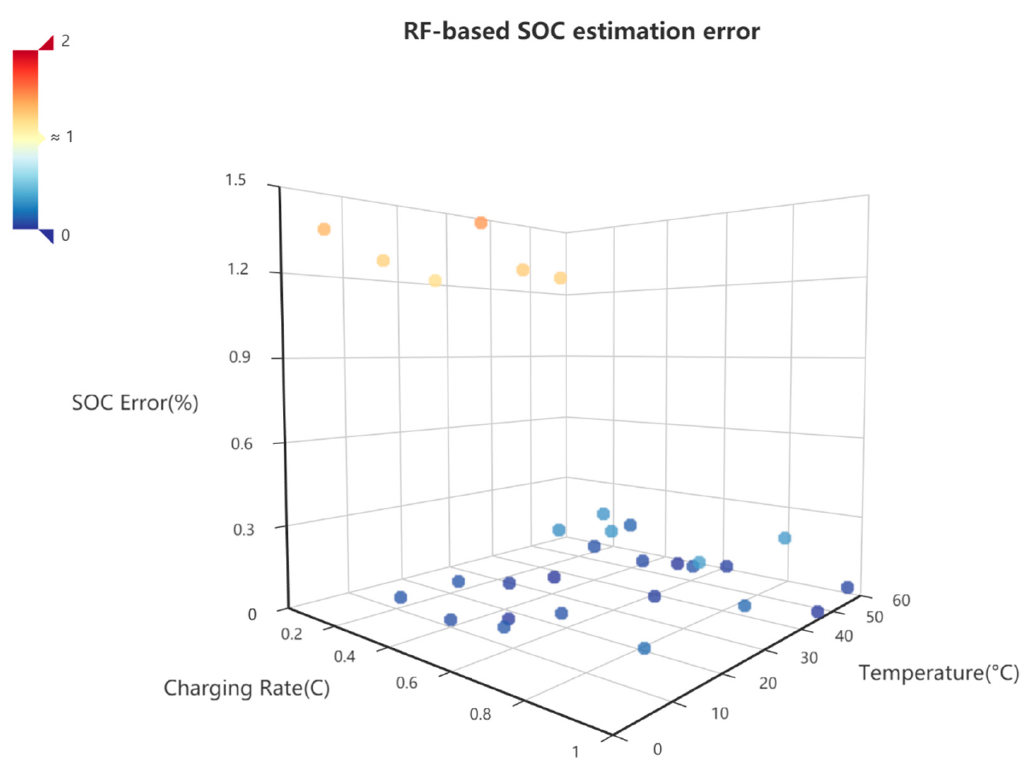
Figure 9. Estimation errors of RF-based SOC prediction in different working conditions.